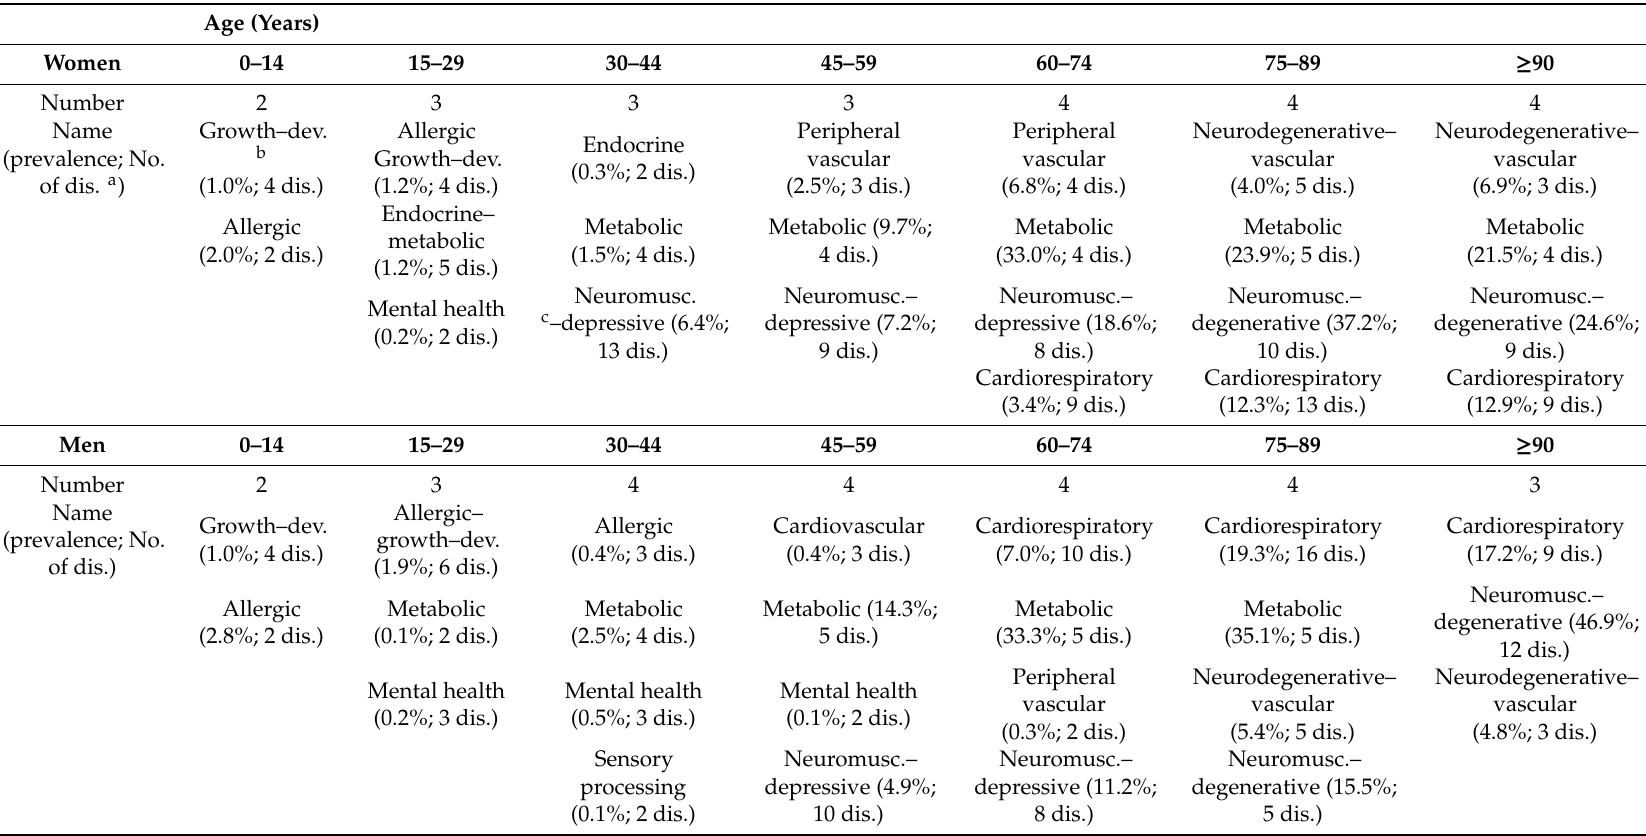
Table 2. Number, denomination, prevalence, and number of diseases of the multimorbidity patterns found in the study population based on sex and